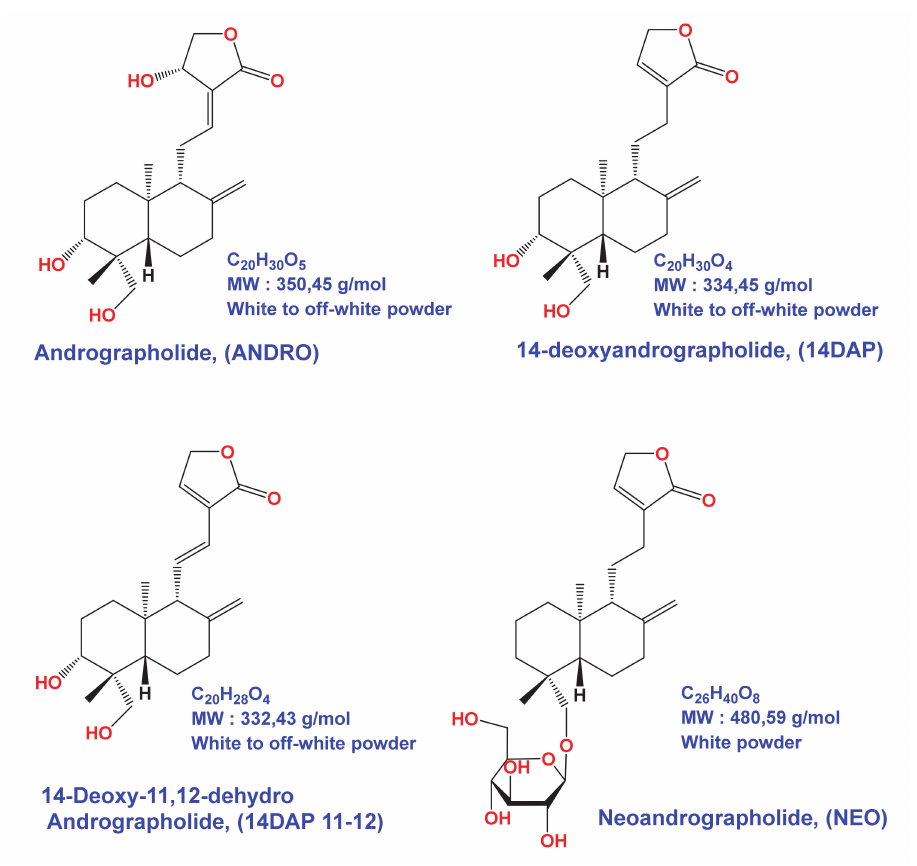
Figure 1. Andrographolide (ANDRO), 14DAP, 14DAP11-12 and neoandrographolide (NEO) molecular